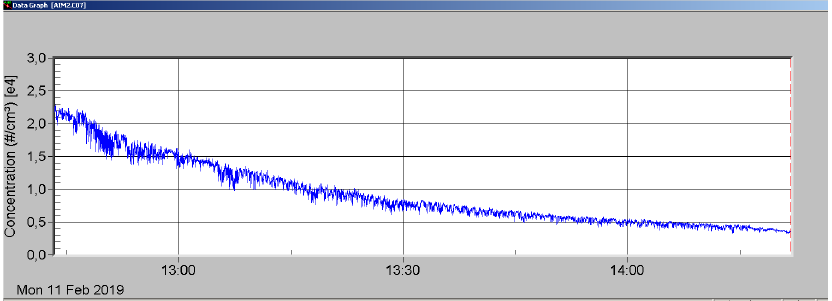
Figure 6 . Nanoparticles during PLA printing (Contaminated with ABS). A (CPC concentration), B (EEPS concentration), C (EEPS size distribution On the 21 st of February, during printing ABS filament, an average concentration of 15,521 particles/cm 3 was observed with the CPC (Figure 7A), and 7,250 particles/cm 3 with the EEPS (Figure 7B) typical submicron particle size distributions are shown in Figure 7C. Most of the particles emitted during printing were less than 200 nanometers with a number peak around 15